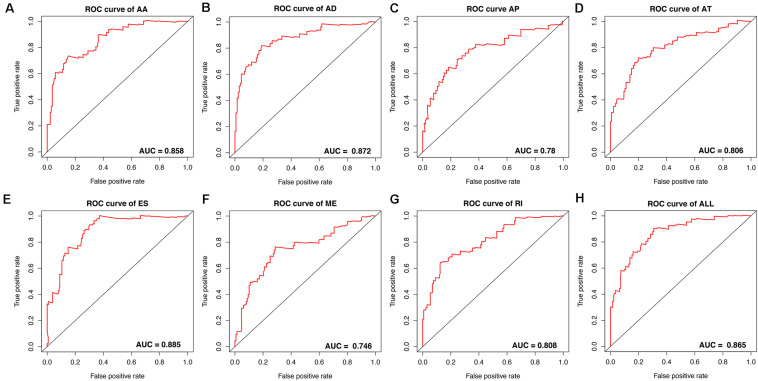
ROC curves with calculated AUC values of prognostic predictors constructed with either one type or all seven AS types in the ESCA cohort. (A) AA: alternate acceptor site. (B) AD: alternate donor site. (C) AP: alternate promoter. (D) AT: alternate terminator. (E) ES: exon skip. (F) ME: mutually exclusive exons. (G) RI: retained intron. (H) ALL: all seven AS types combined.